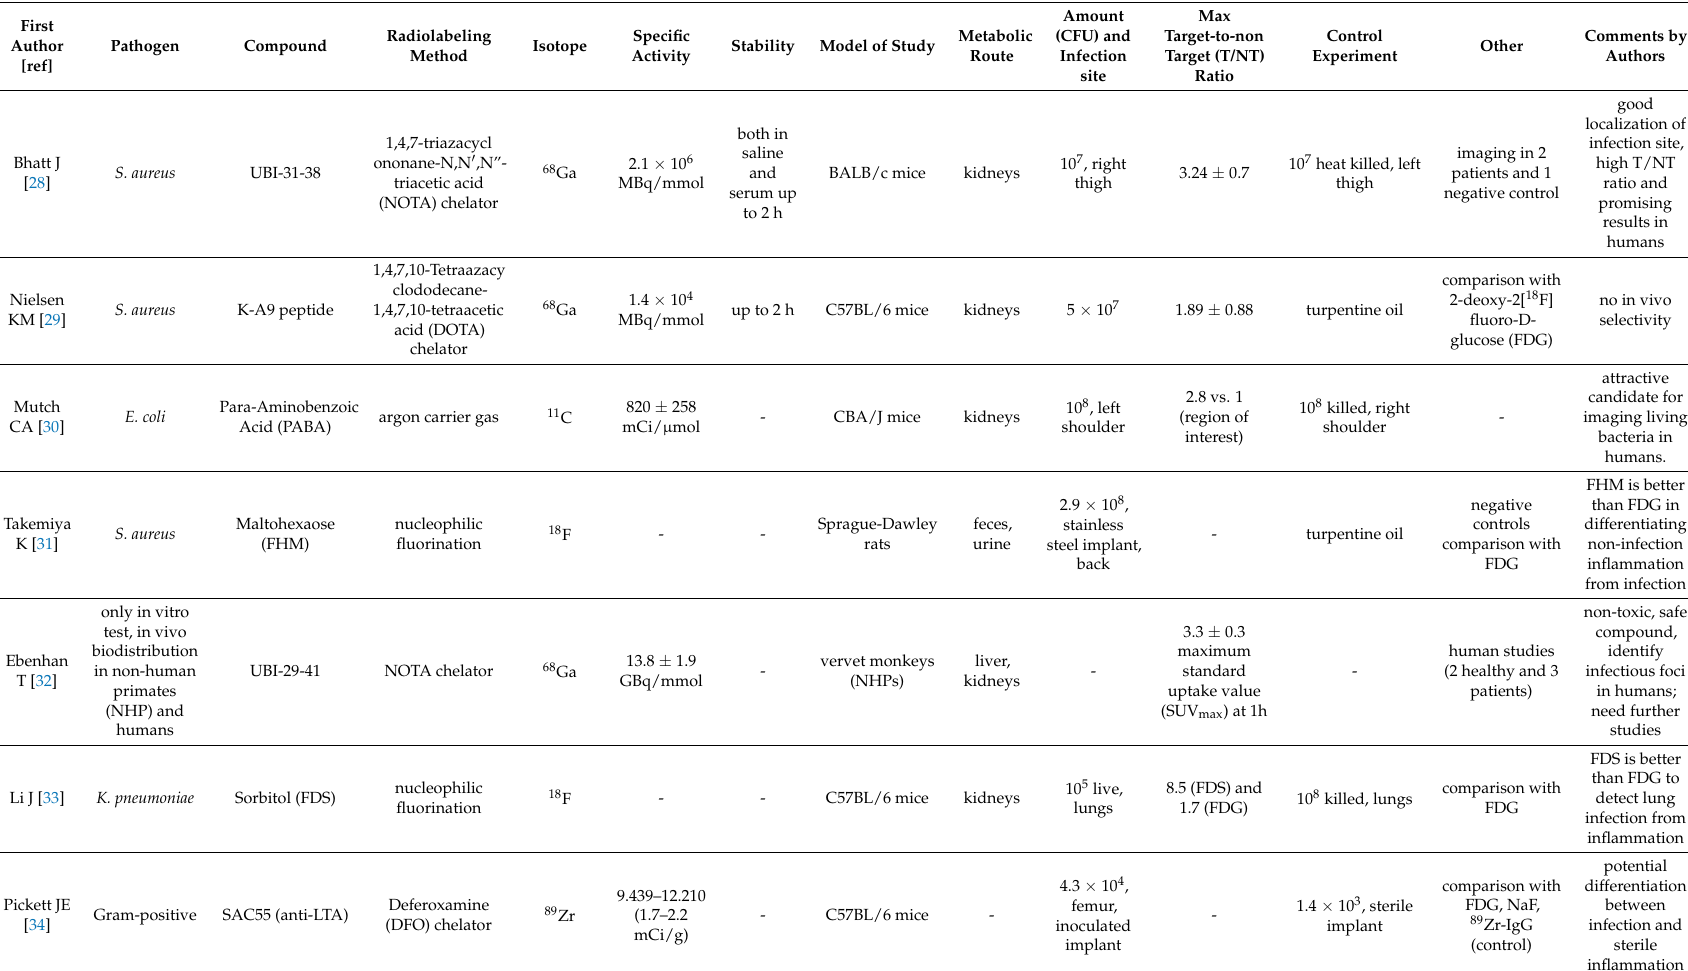
Table 1. Summary table of papers included in the systematic